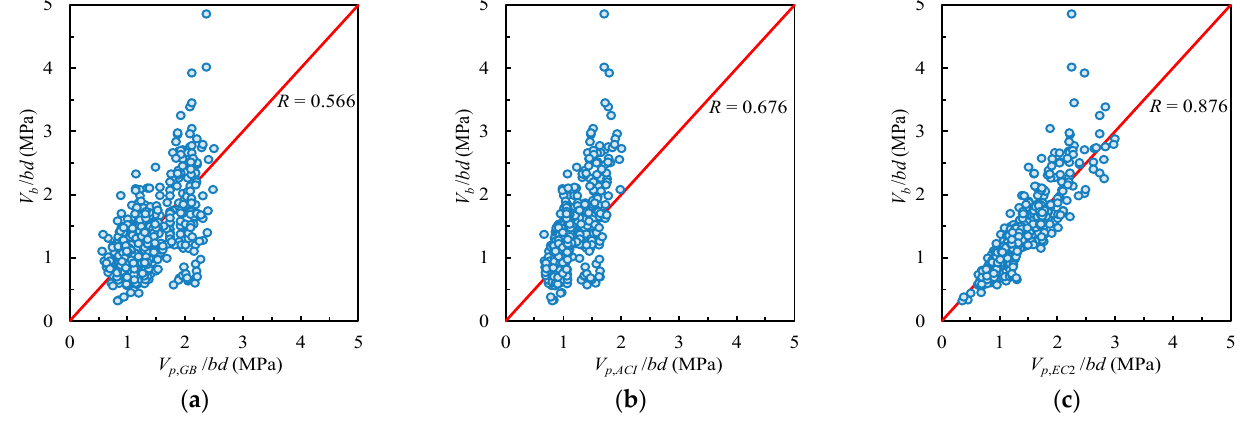
Figure 3. Comparison of model predictions with test results. ( a ) EC2. ( b ) ACI. ( c ) GB.